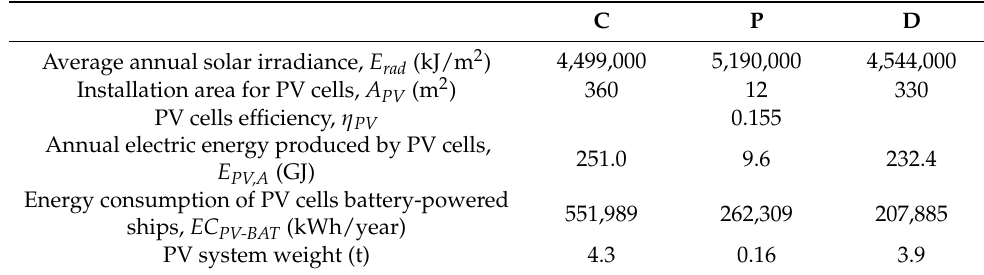
Table 7. PV cell battery-powered ship input data for LCA.